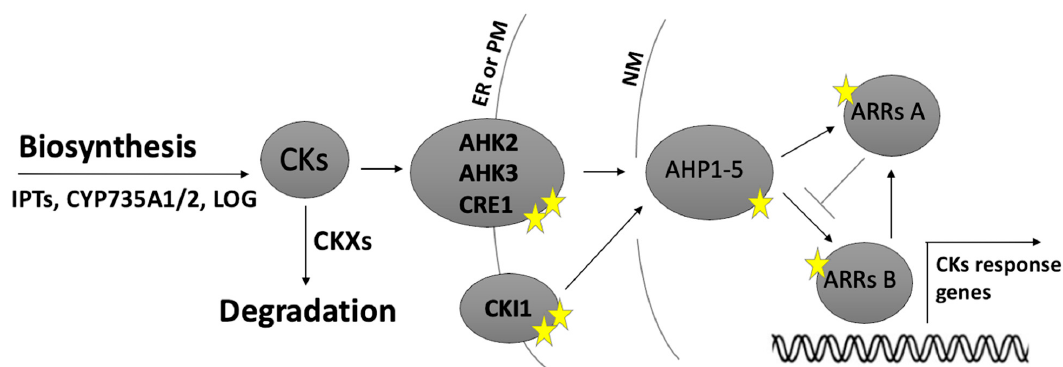
Figure 1. An overview of the cytokinin (CK) pathway from biosynthesis to response in Arabidopsis. CKs are synthesised by isopentenyltransferases (IPTs) and CYP735A1/2 enzymes and converted into active forms by LONELY GUY (LOG) enzymes, whereas cytokinin degradation occurs